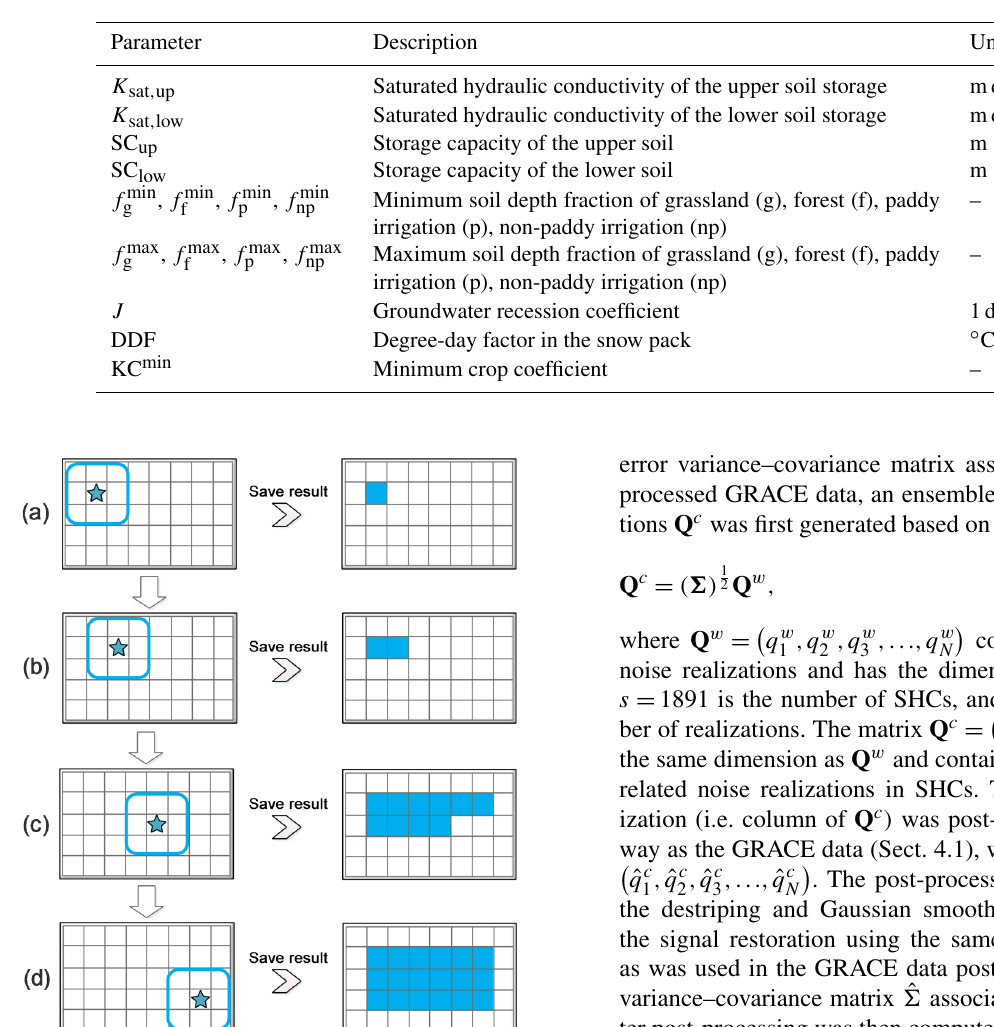
Table 1. PCR-GLOBWB model parameters related to the TWS estimate. Parameters are functions of spatial coordinates, except the degree- day factor (DDF), which is a constant.